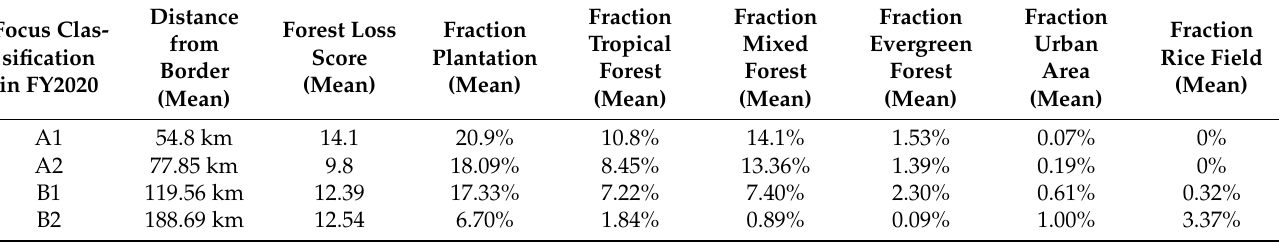
Table 2. Environmental characteristics across foci classification. The table shows the mean (among all foci in each classification) percentage of land covered by each environmental feature.